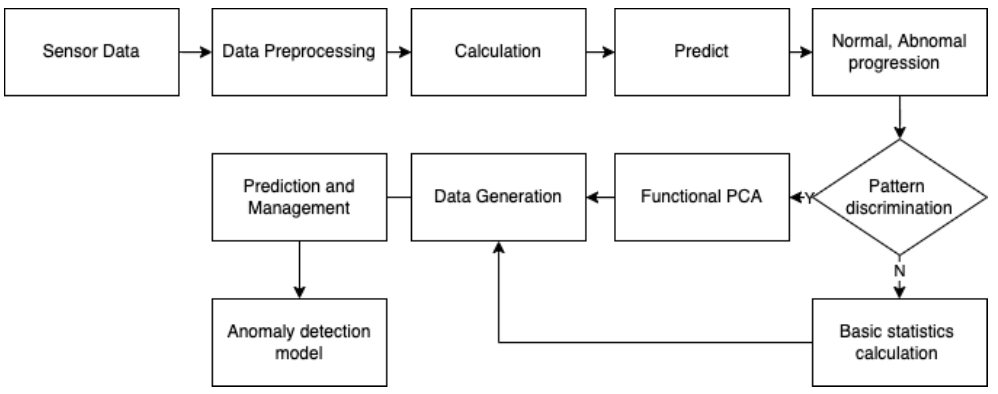
Figure 1. Anomaly detection procedure in smart